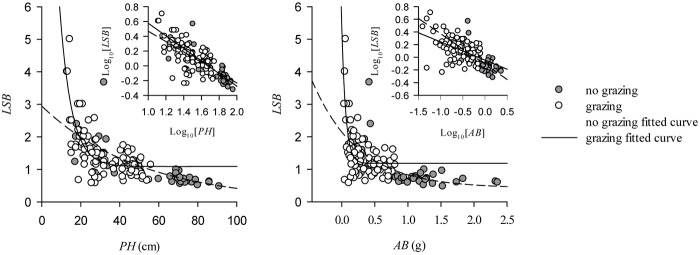
Effect on aboveground biomass allocations of the overgrazing-induced variation in the size of L. chinensis individuals.The leaf to stem biomass ratio of L. chinensis individuals is fitted to an exponential decay relation as a function of PH and AB. In the non-grazing group, the leaf to stem biomass ratio is significantly affected by PH (R = -0.78, P<0.001) and AB (R = -0.67, P<0.001). The leaf to stem biomass is also significantly affected by PH (R = -0.75, P<0.001) and AB (R = -0.64, P<0.001) in grazed plots. Overall, PH (R = -0.73, P<0.001) and AB (R = -0.62, P<0.001) significantly influence leaf to stem biomass (insets). The gray arrows in the figures show the shifts in the slopes of the exponential decay relations as a result of overgrazing.